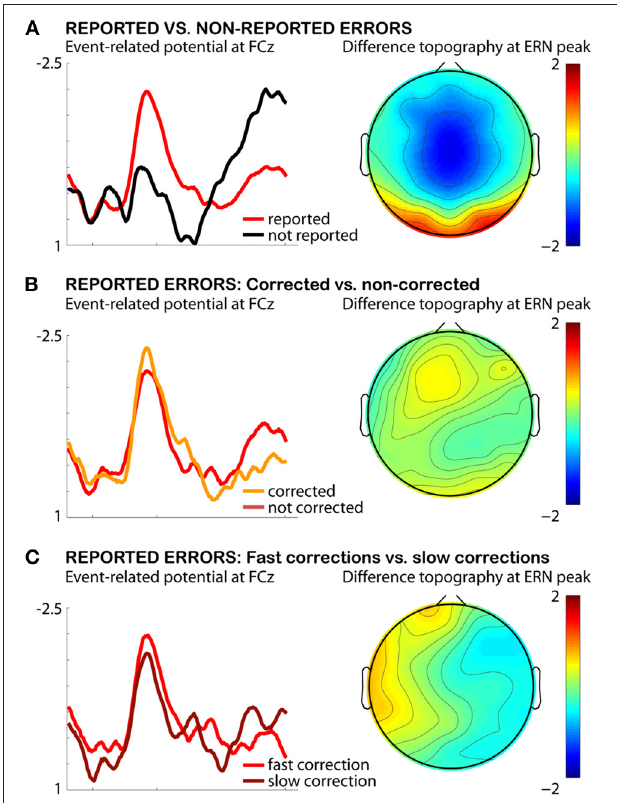
FIGURE 2 | Testing the error-correction hypothesis of ERN amplitude in the AST. Depicted are the combined data from both experiments in Wessel et al. (2011), limited to the 24 subjects that exhibited enough errors to warrant statistical comparison. (A) Difference between reported and non-reported errors in this sample. (B) Difference between corrected and non-corrected reported errors. (C) Difference between reported errors with fast corrections and reported errors with slow